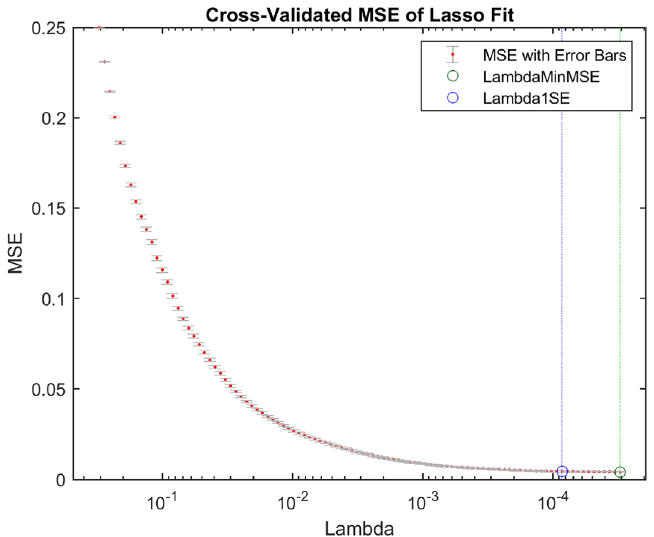
Figure 10. The LASSO fit using the DFs of the fc7 layer.